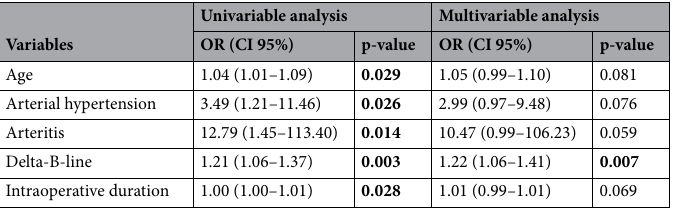
Table 3. Univariable and multivariable logistic regression analysis for postoperative pulmonary complications. Significant values are in bold. Values are odds ratio (OR) with 95%